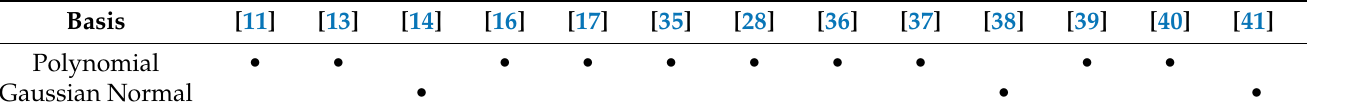
Table 6. Basis for the field.